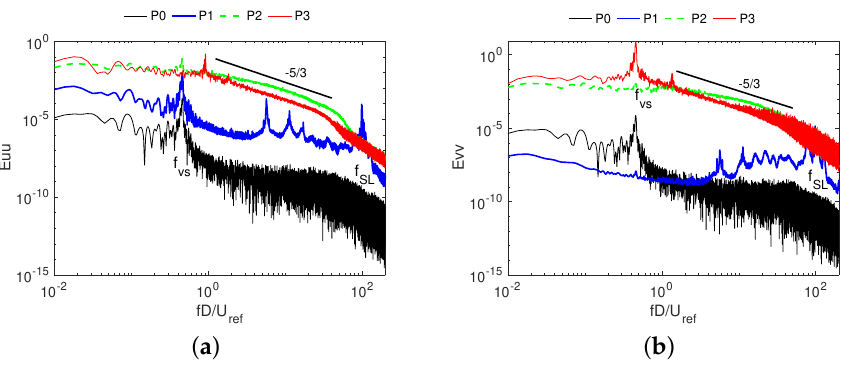
Figure 12. Energy spectra at different locations. ( a ) for stream-wise velocity fluctuations, ( b ) for cross-stream wise velocity